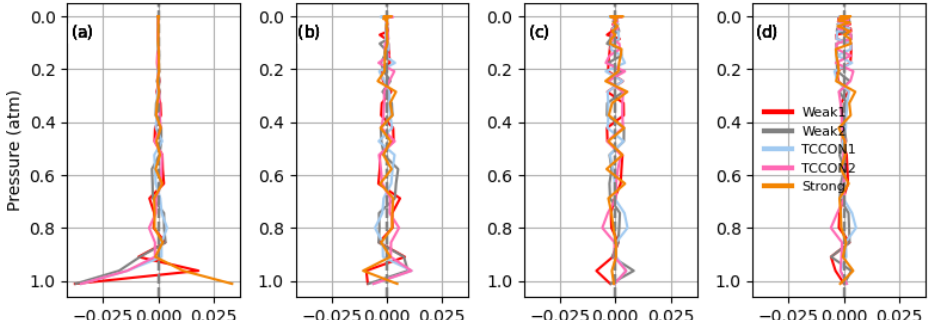
Figure D6. The four largest error patterns of the null space covariance matrix for a Lamont spectrum measured on 14 January 2012.